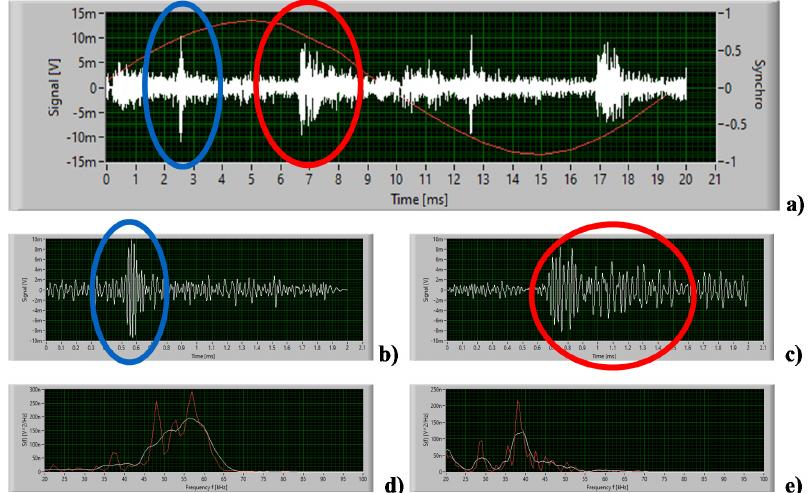
Figure 8. ( a ) The recorded AE signal with a duration of one period of the supply voltage (20 ms); ( b , c ) two time structures separated from the signal; ( d , e ) Fourier transforms of signals from Figure 8b and 8c (respectively).